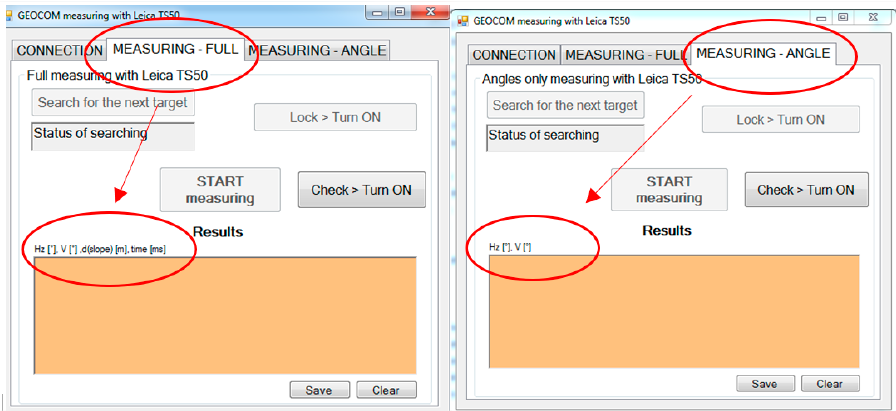
Figure 3. The GeoCOM/ZG program ( left : all measurements, right : only measuring angles).